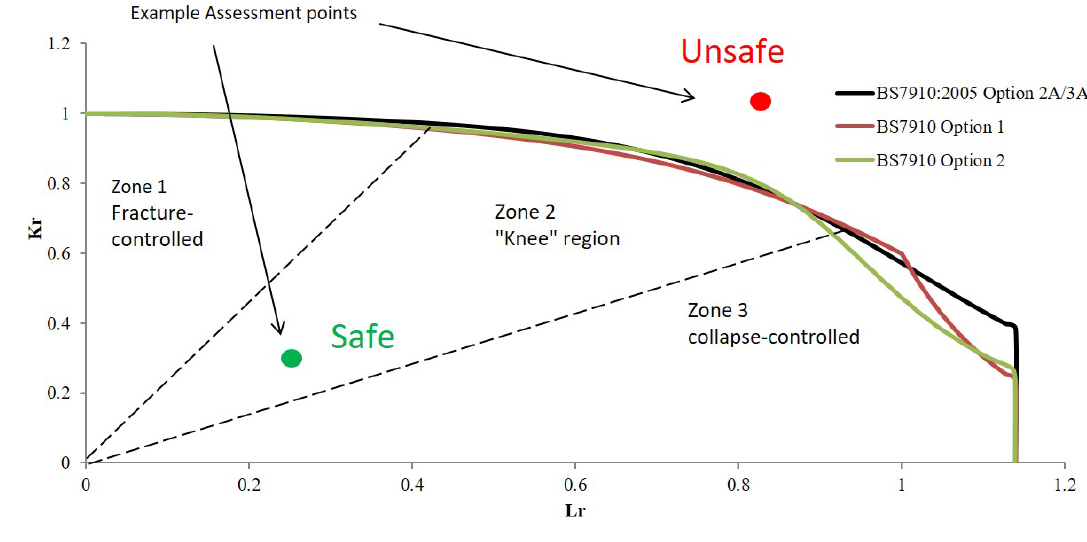
Figure 7. Failure assessment diagram (FAD) (Amirafshari, 2019).